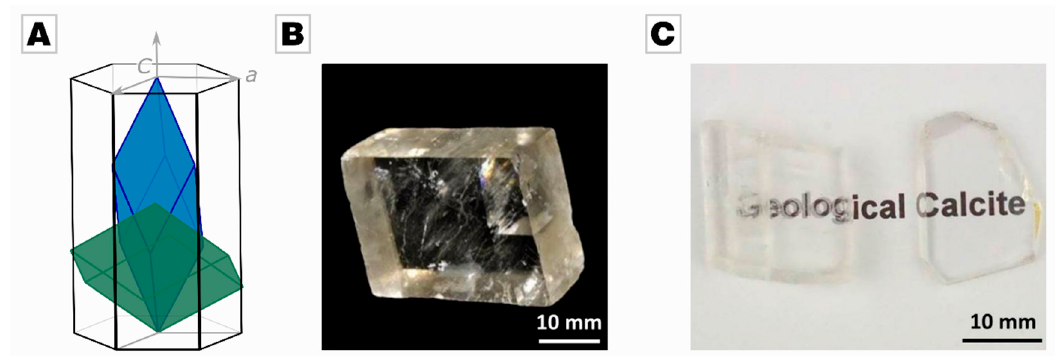
Figure 1. ( A ) Crystallographic unit cells of calcite; elongated rhombohedron (blue) and hexagonal (black) in relation to the cleavage rhombohedron (green). The c -axis is the extraordinary axis of calcite. ( B ) A typical calcite rhombohedral as found in nature; the {104} set of planes represent cleavage planes along which calcite readily fractures. ( C ) Birefringence is absent when the optical axis parallel to the extraordinary axis of calcite.